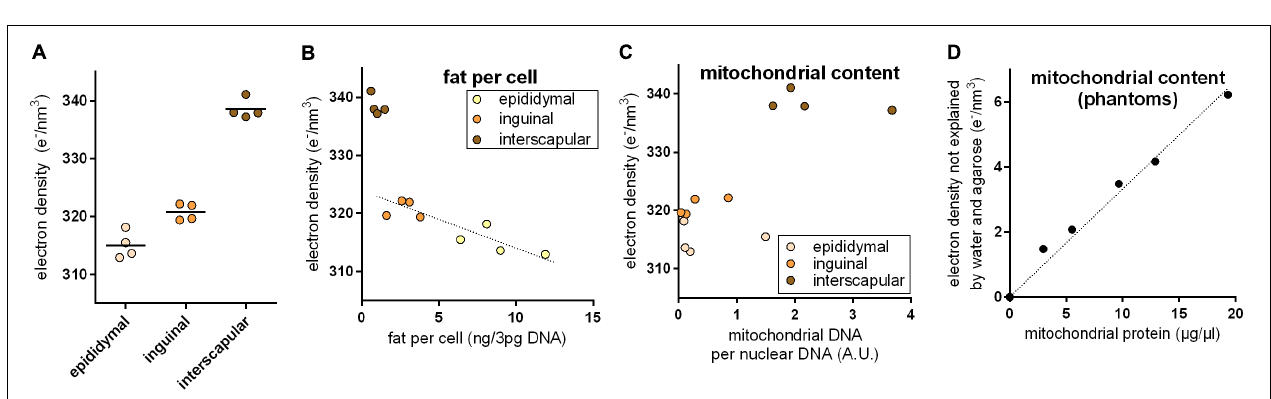
FIGURE 2 | (A) Electron density of explants from the epididymal white, inguinal brite, and interscapular brown adipose tissue depot. Electron density increased with assumed brown adipocyte content. (B) Electron density of white adipose tissue explants correlated with fat content per cell, and while brown adipose tissue was electron denser than expected from fat content. The dotted line represents a linear regression across inguinal and epididymal explants ( R 2 0.78, p < 0.05). (C) High electron density in brown adipose tissue coincided with high mitochondrial content. (D) In agarose phantoms with varying additions of embedded mitochondria, mitochondrial protein content correlated with residual electron density. The dotted lined represents a linear regression across all phantoms ( R 2 0.98, p < 0.05).